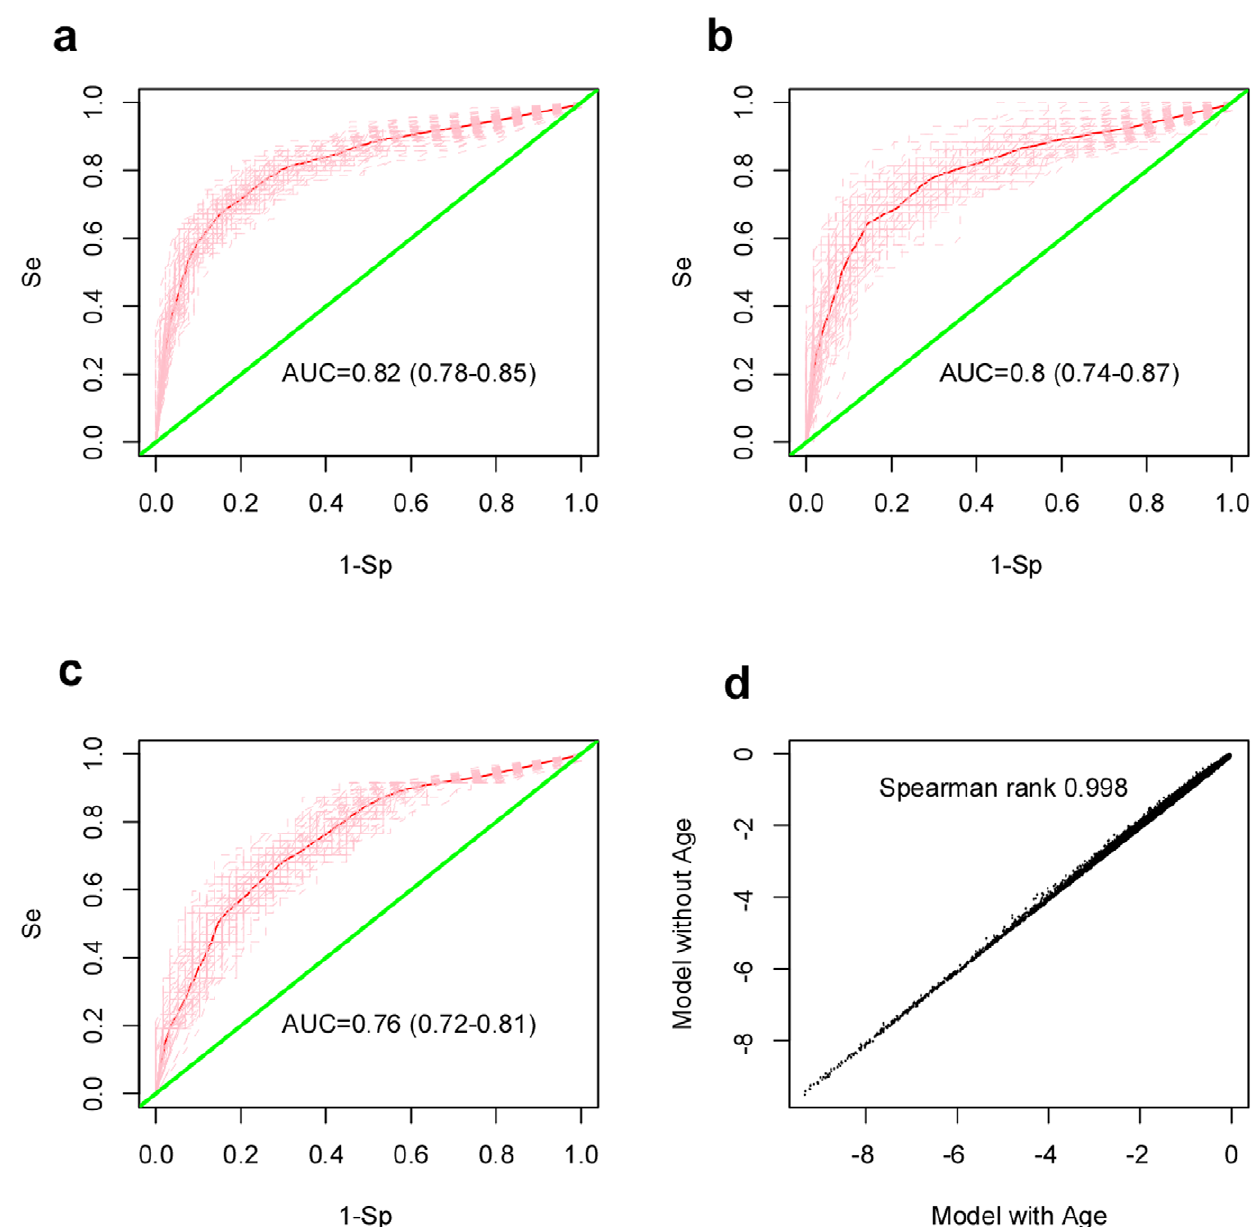
Figure 1. Prediction of tumor presence by a DNAm signature in blood. a–b ) Classification performance of DNA methylation classifiers in a ) training sets and b ) blind test sets. Training and test sets consisted of blood samples from pre-treatment cases and healthy individuals (Materials and Methods). Average ROC curve over 100 different training/test set partitions with 95% CI envelope in blind test sets. Mean AUC and 95% CI over 100 different partitions are given. c ) Classification performance in test sets consisting of healthy controls and post-treatment samples with evidence of active disease. d ) Correlation between the ranking of top CpGs discriminating pre-treatment cases from healthy controls in regression models that included age (x-axis) and without age (y-axis) as a co-factor. Plotted are the log10(p-values) for the 25,642 CpG sites, as evaluated from multiple logistic regressions of case/control status against the CpG methylation profile with age as a co-factor (x-axis) and without age as a co-factor (y-axis). Spearman correlation between the two rankings is given.